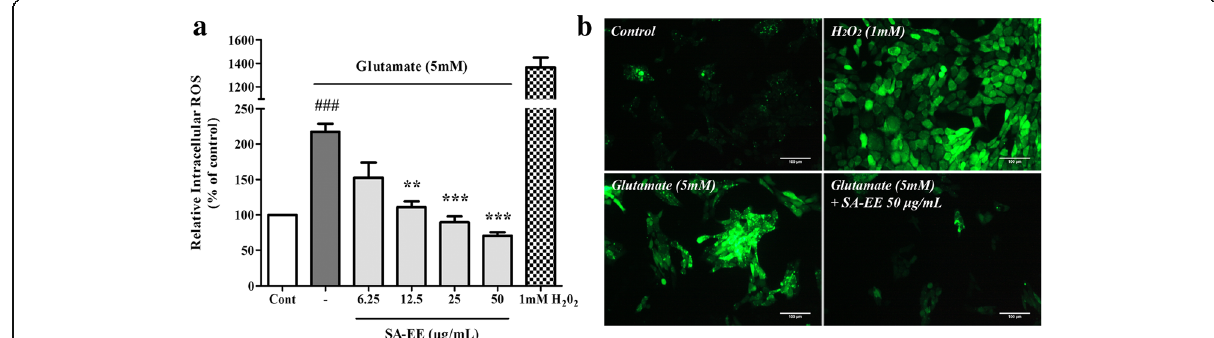
Fig. 2 Protective effect of SA-EE against glutamate-induced oxidative stress in HT22 cells. HT22 cells were exposed to 5 mM glutamate alone or glutamate in combination with different concentrations of SA-EE for 14 h before staining with DCFH-DA probe. H 2 O 2 -treated cells were used as a positive control. Intracellular ROS production was measured using a fluorescent plate reader ( a ). Representative fluorescence micrographs of the cells stained with DCFH-DA was observed under a fluorescence microscope ( b ). All data are shownas the mean±SEM of at least three independent experiments. ### P <0.001 vs. control; **P <0.01, ***P <0.001 vs. glutamate